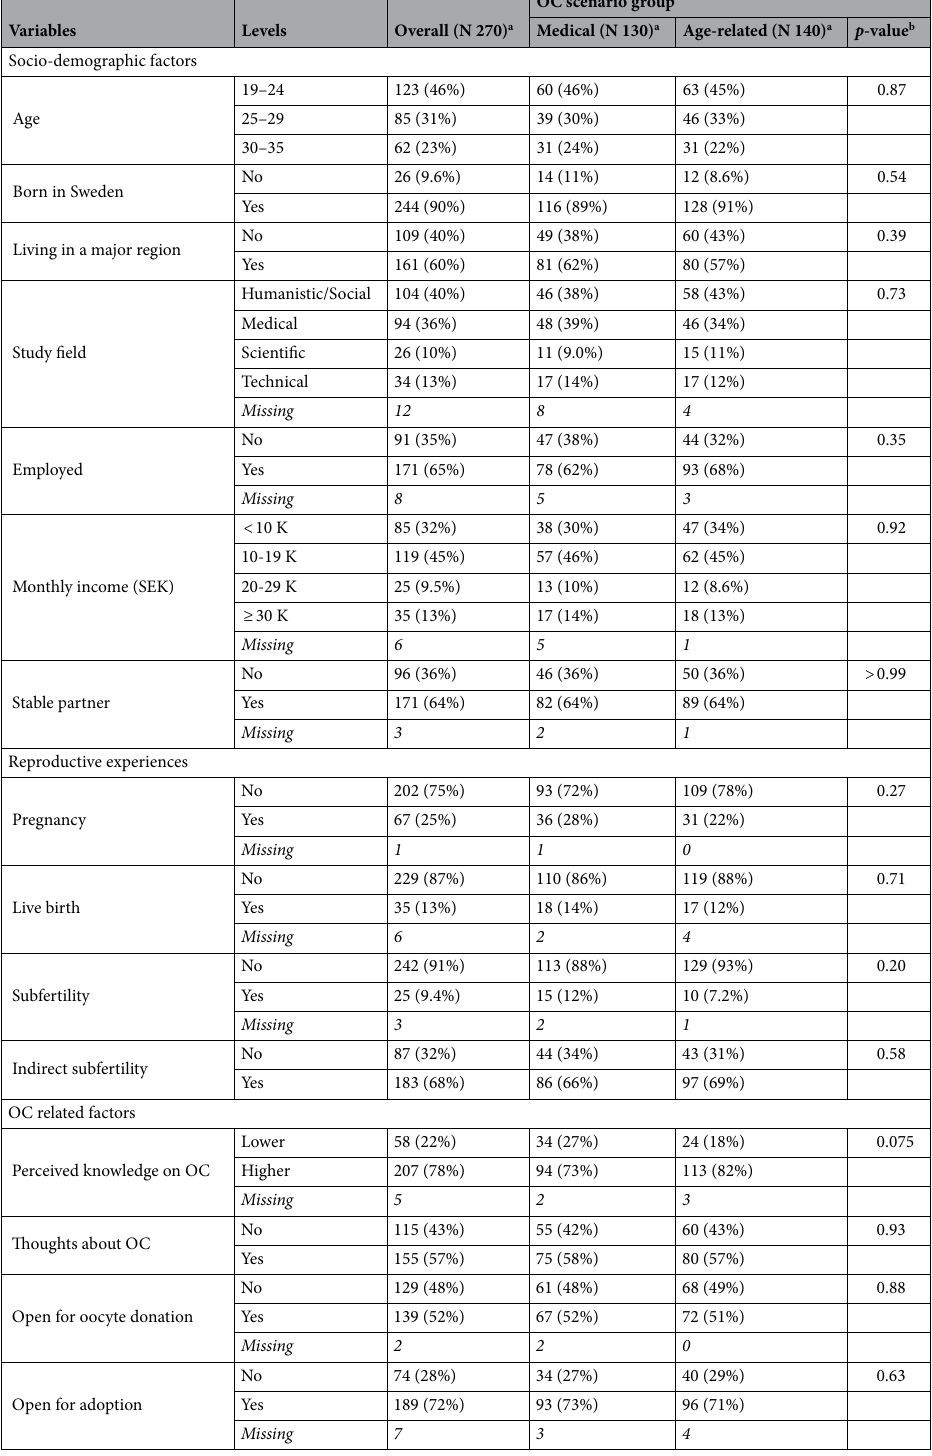
Table 1. Characteristics of the study population. OC, oocyte cryopreservation. a N (%). b Pearson’s Chi-squared test or Fisher’s exact test (with expected cell frequencies < 5). Missing observations (n) are in